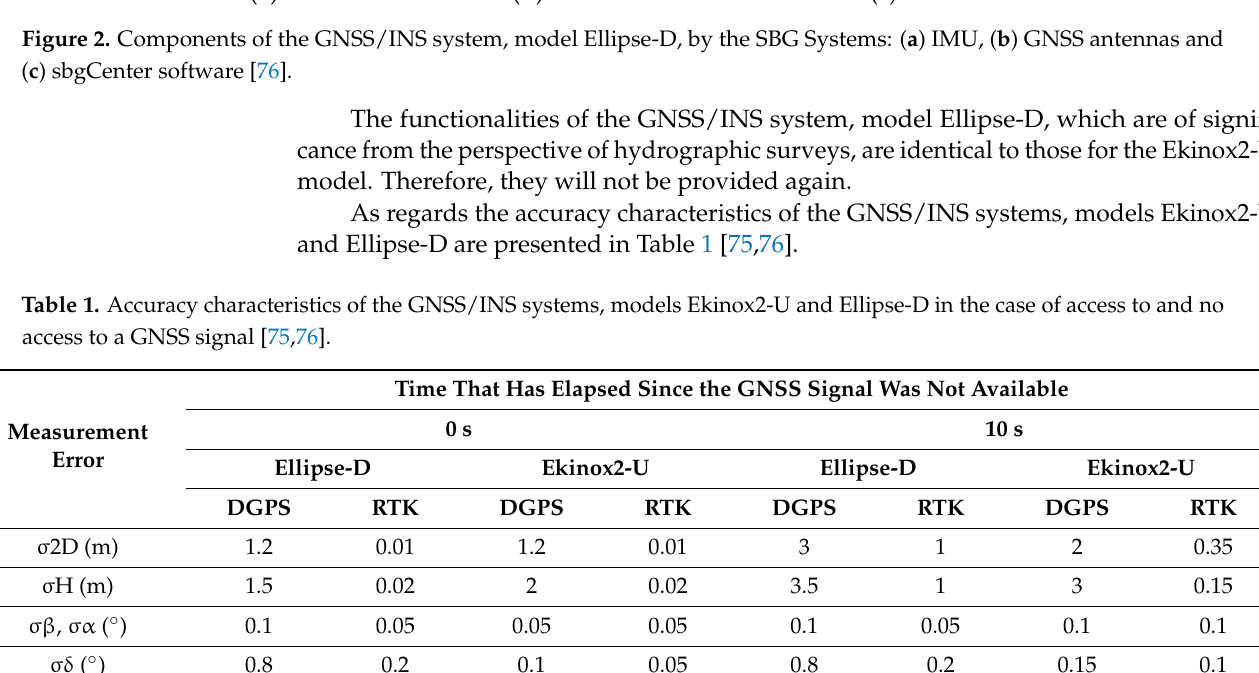
Measurement Error